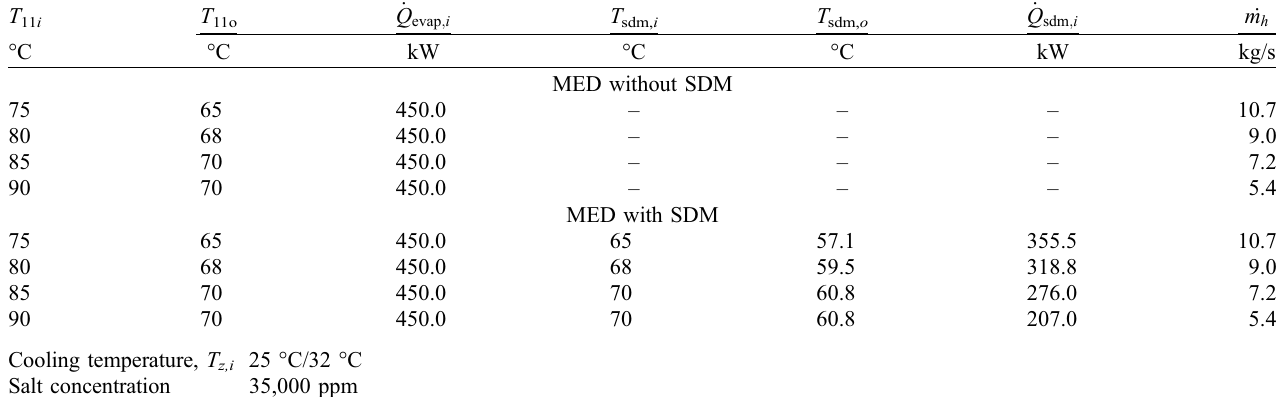
Table 1. The operating conditions for the four and six effect distillation